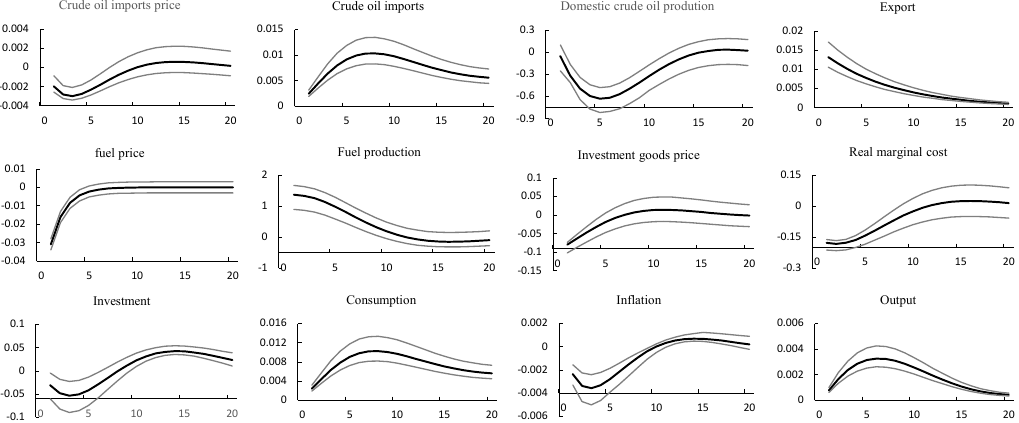
Figure 4. Positive international oil supply shock. (Note: The black solid line represents the estimated actual mean responses, and the gray solid lines represent the 5 percent and 95 percent posterior interval).